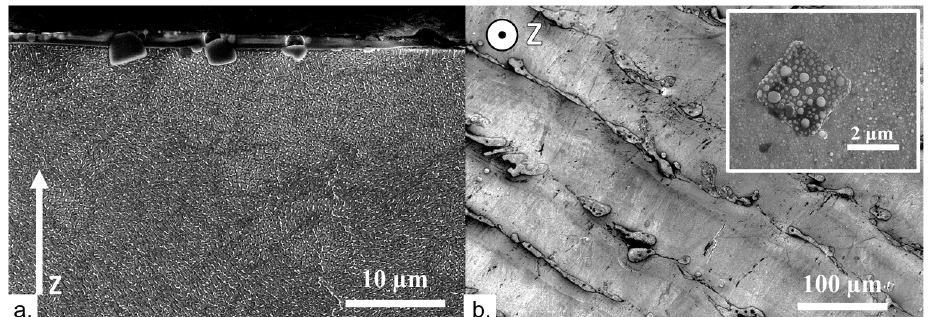
Figure 6. ( a ) Micrograph of the cross-section at the top of the uppermost last deposited layer, and ( b ) top view of a cube produced under argon and 50 ppm residual O 2 . The insert depicts the presence of titanium-rich nitrides on the top surface.